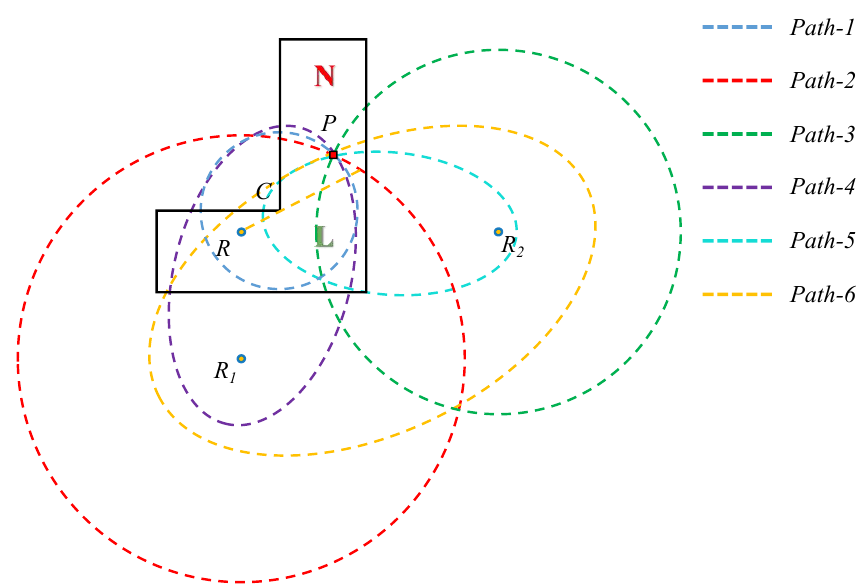
Figure 2. Six paths intersect at the target point in L-shaped corner scenario.